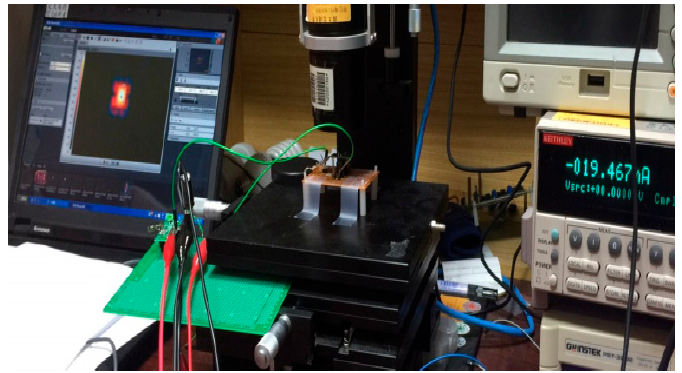
Figure 5. Experimental apparatus to measure parameters of the microheater circuit.